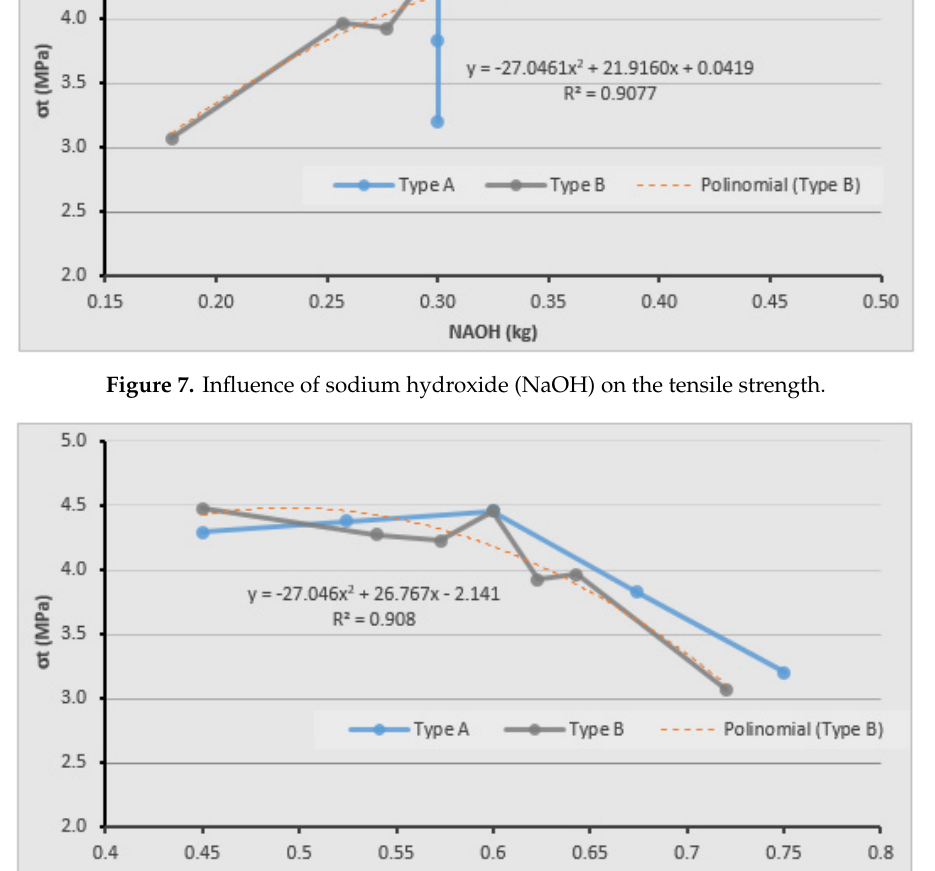
Appl. Sci. 2020 , 10 , x FOR PEER REVIEW Figure 8. Influence of sodium silicate (Na2SiO3) on the tensile strength. Figure 8. Influence of sodium silicate (Na2SiO3) on the tensile strength.